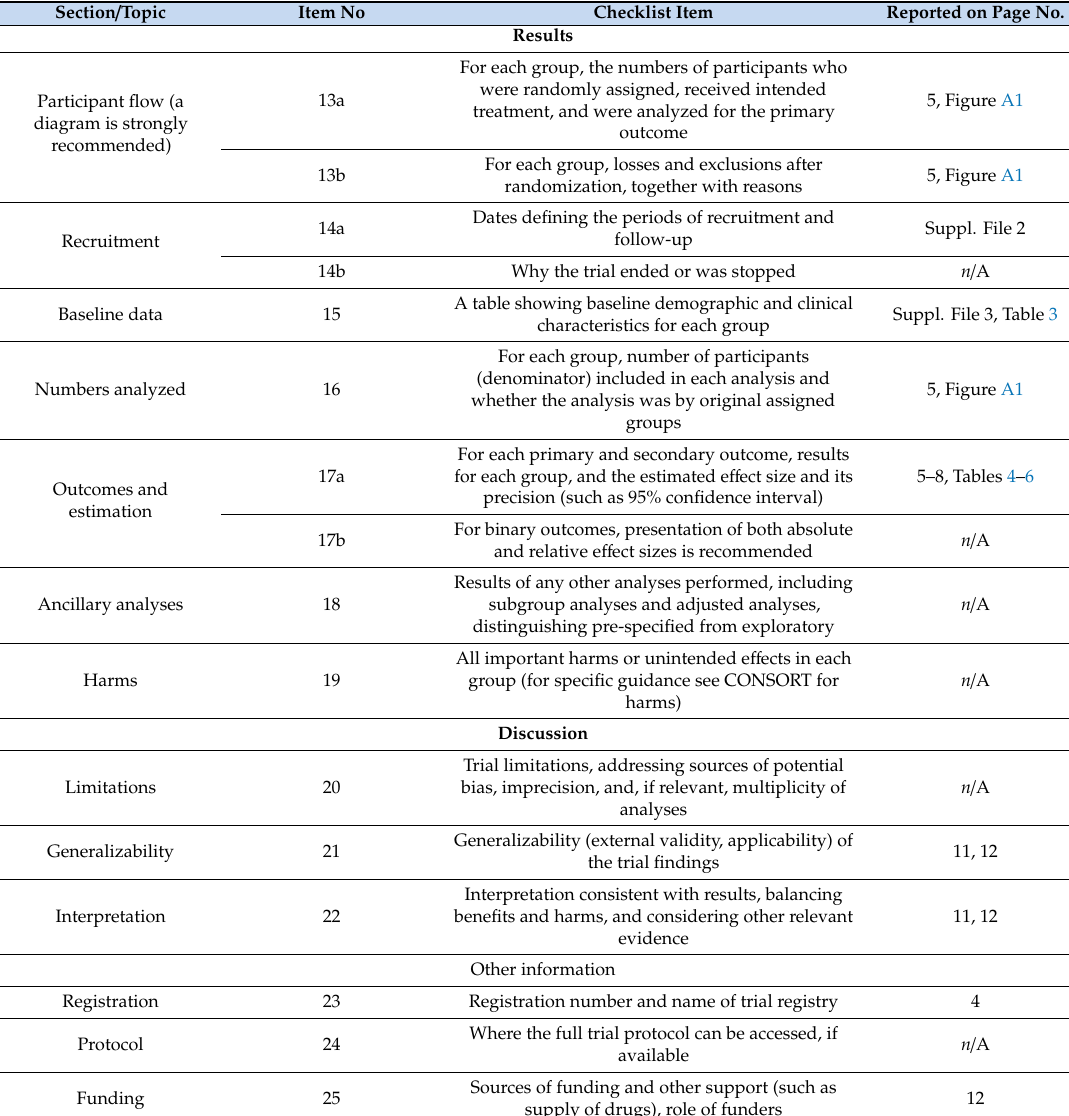
Suppl. File 3, Table